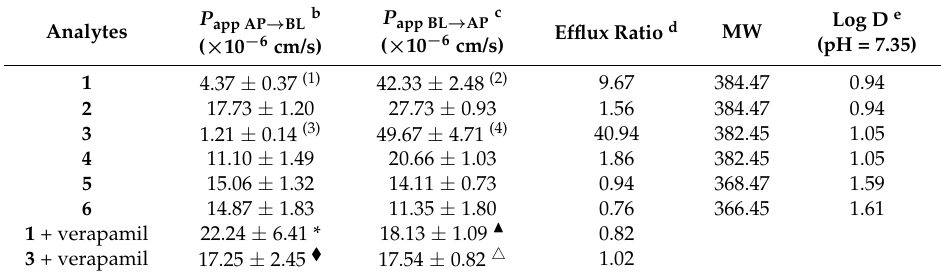
Table 4. The bidirectional P app values, efflux ratios of alkaloids 1 – 6 a and verapamil